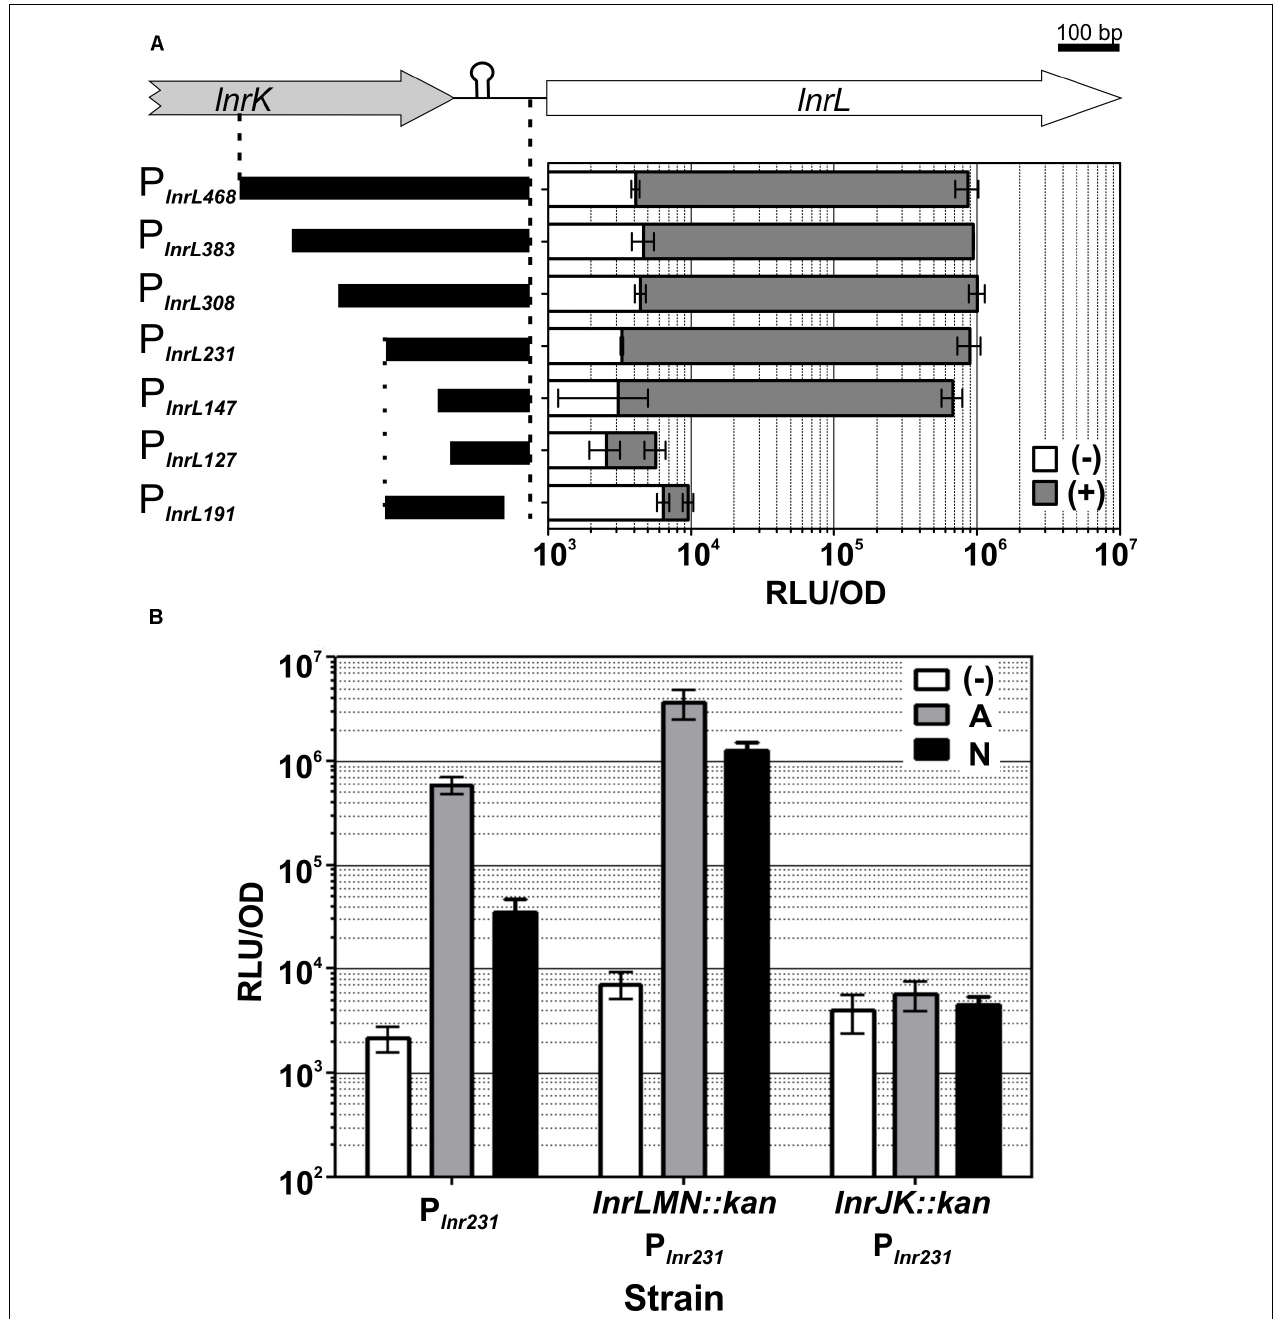
FIGURE 4 | LnrJKLMN system characterization. (A) Identification of the minimal lnrL promoter fragment. The genetic region containing the P lnrL promoter, the promoter truncations constructs and their functional analysis are presented. The genes lnrK (block gray arrow) and lnrL (block white arrow) are depicted; the length of the initial P lnrL 468 promoter is indicated by vertical dashed lines. The vertical dotted line indicates the beginning of the 3’ promoter truncation. Rho-independent transcriptional terminator between lnrK and lnrL is indicated by a hairpin. Schematics of P lnrL promoter truncations are drawn as black bars on the left side. Genes and promoter fragments drawn to scale. Promoter activities one hour after induction with 4 µ g ml - 1 of amphotericin B (gray bars) relative to the activities of the uninduced promoters at the same time point (white bars), are presented in the right graph as relative luminescence units by OD 600 . (B) Mechanism of sensing. The activity of P lnrL 231 in response to amphotericin B and nystatin was determined in a wild type background (strain TMB4223), in a mutant eliminated in the lnrLMN transporter (strain TMB5423) and in a mutant eliminated in the lnrJK TCS (strain TMB5422). The promoter activity at one-hour post induction with amphotericin B 4 µ g ml - 1 (gray) and nystatin 167 µ g ml - 1 (black) is presented relative to the uninduced state (white), as relative luminescence units by OD 600 . The chosen concentrations of the compounds correspond to the maximum promoter induction, as indicated by the data shown in Fig. 5. The experiments were performed in quadruplicate with two independent clones; means and standard deviations are